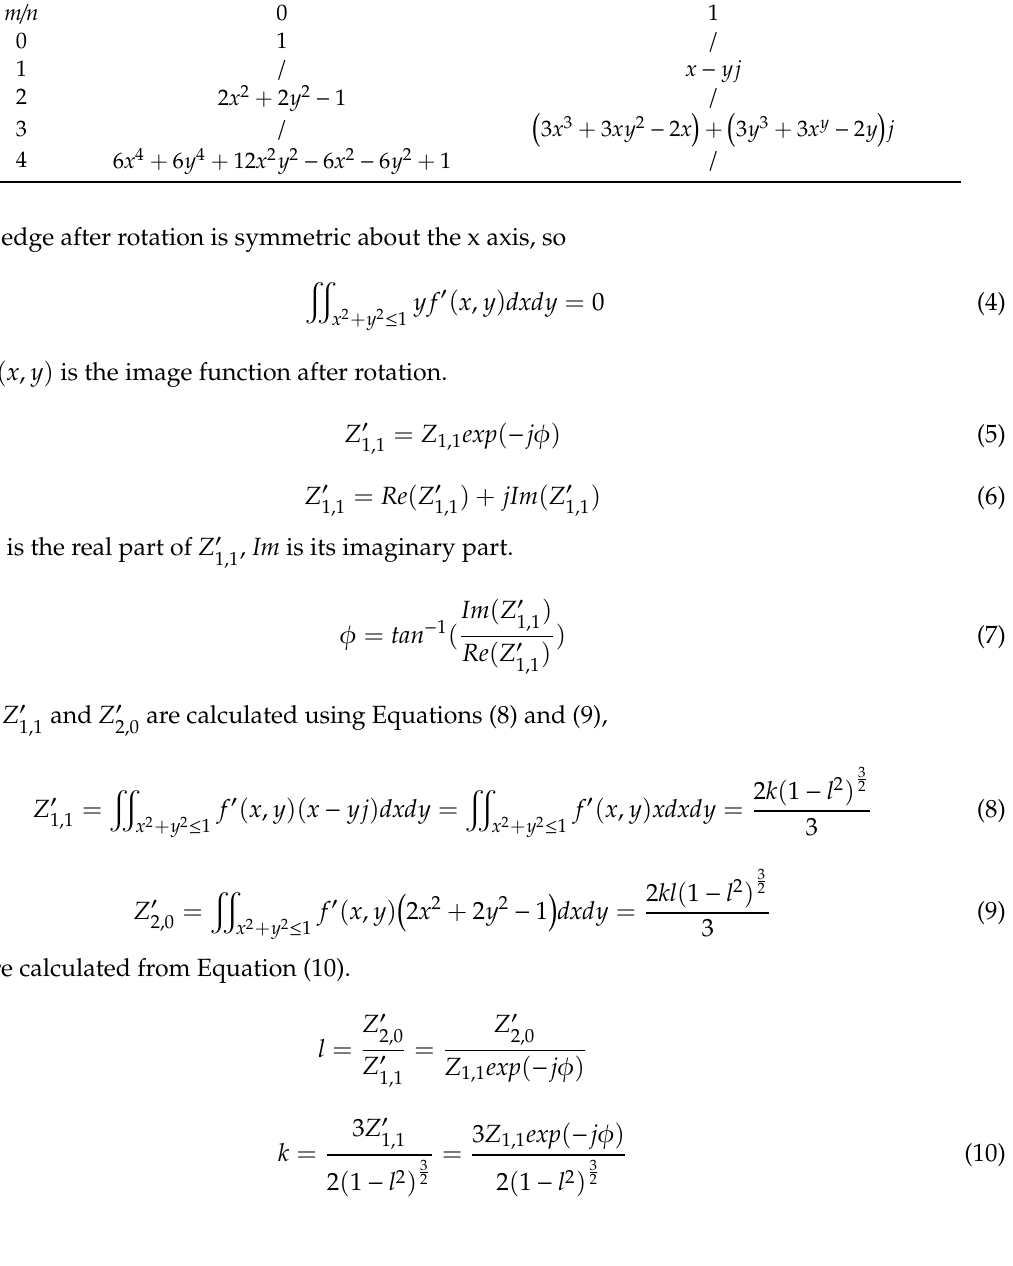
Figure 3. Model of edge: ( a ) Original edge and ( b ) Edge after rotation.